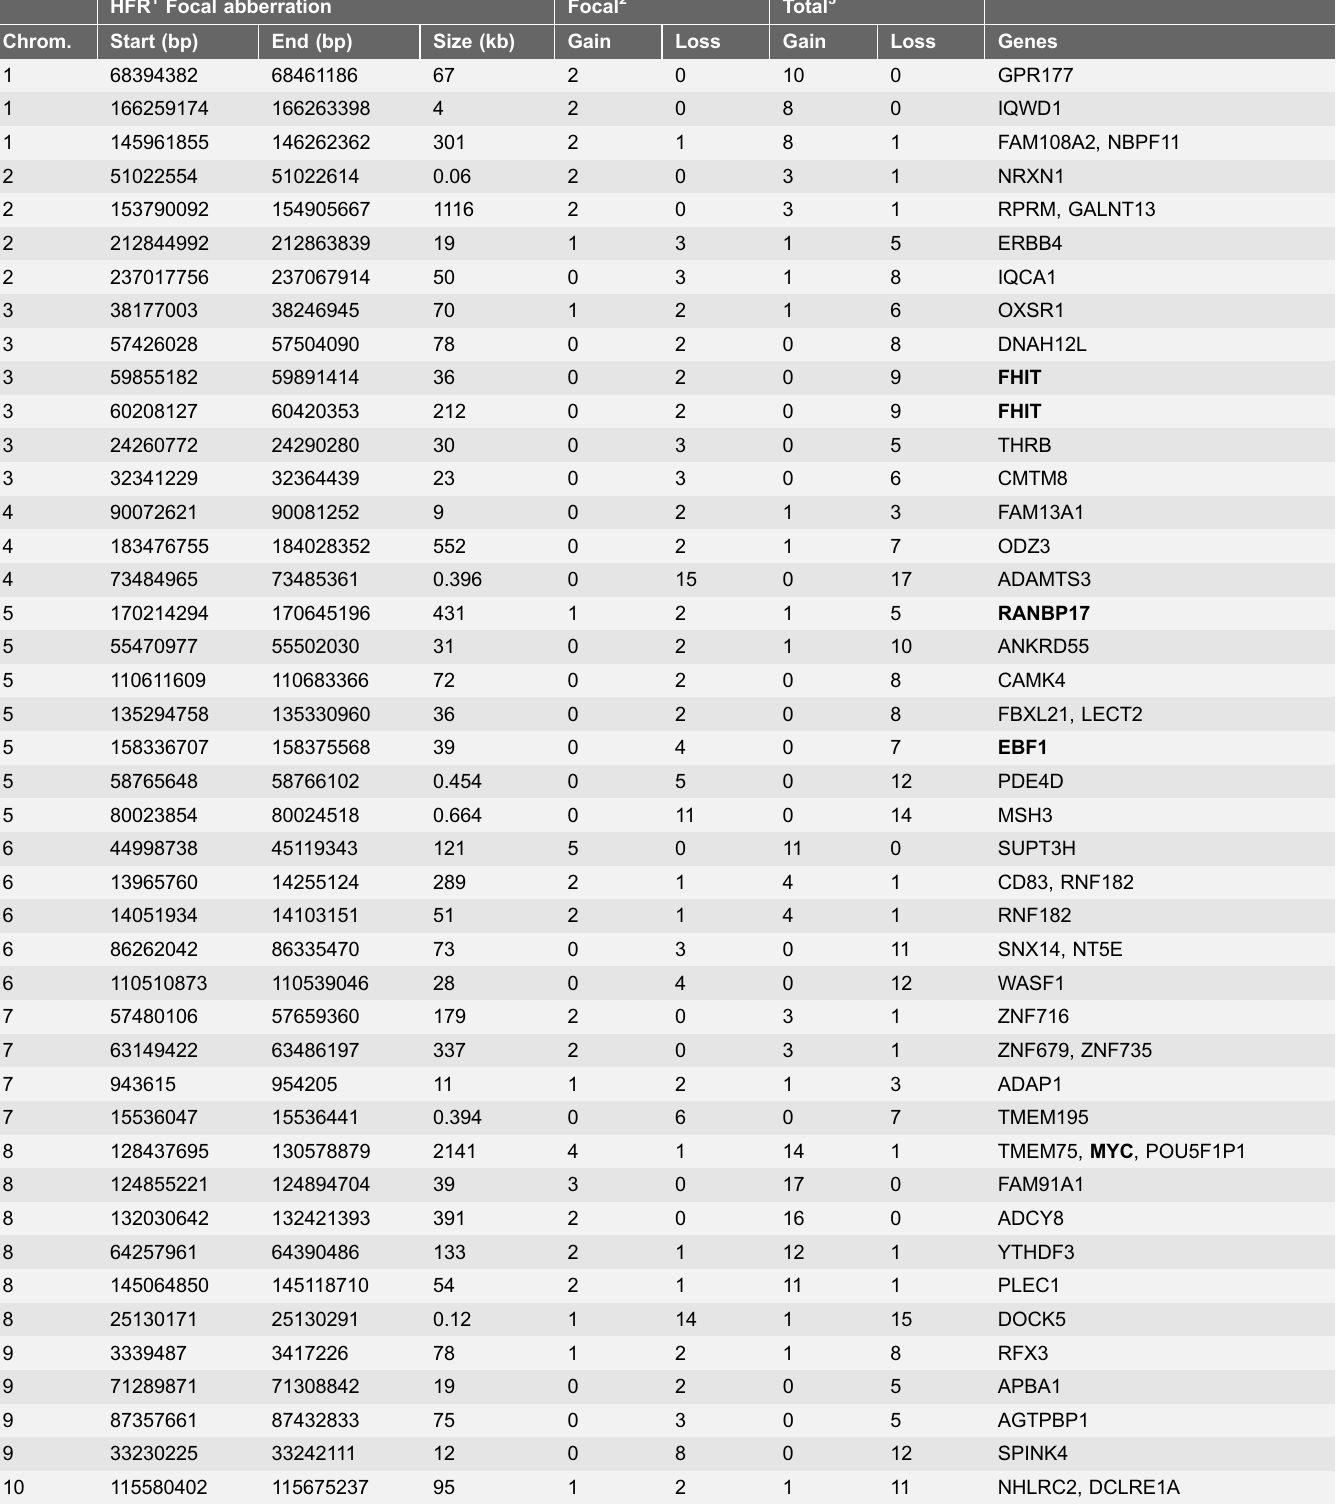
Table 2. High frequency regions (HFRs) of focal aberrations and gene(s) within or overlapping these HFRs. HFR 1 Focal abberration Focal 2 Total